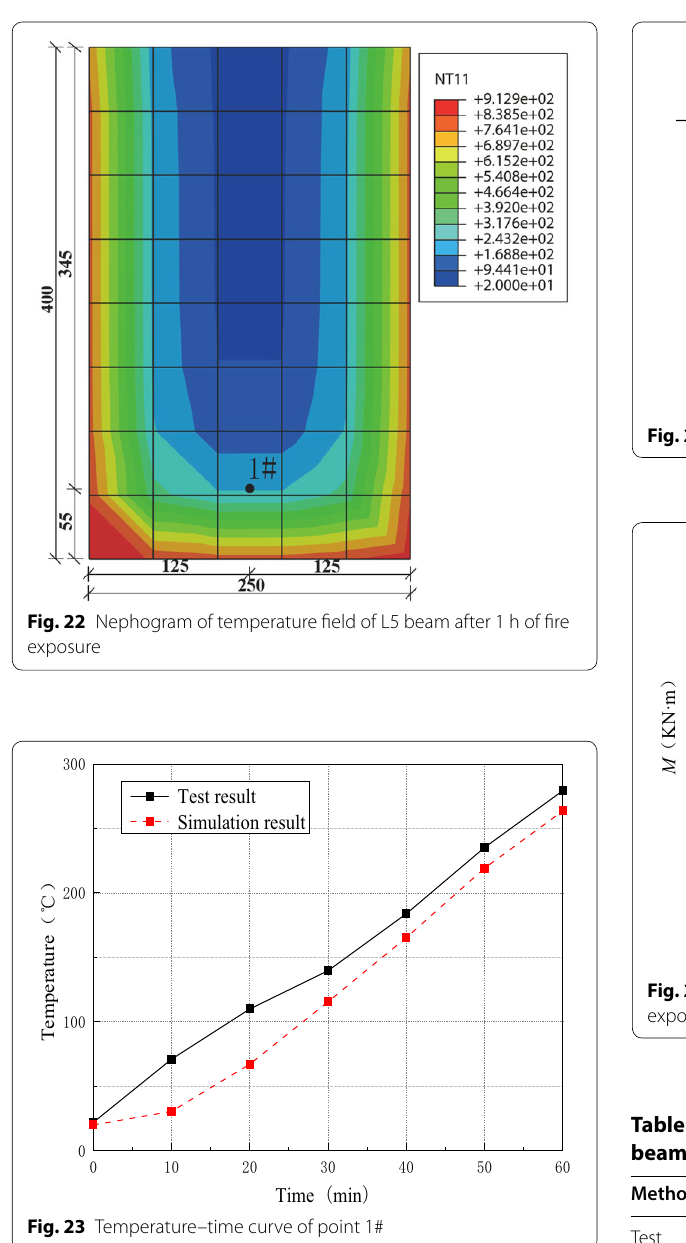
To more comprehensively compared the accuracy of the improved section method, the 500 °C isotherm method from Eurocode (BSI 2004) is now used to calcu- late the L5 beam. For a rectangular beam exposed to fire on three-sided, the schematic diagram of effective sec- tion of the beam is shown in Fig. 24. In fact, the 500 °C isotherm method is a rough calculation method for the residual flexural capacity of the beam after fire. It is based on the assumption that concrete outside 500 °C no longer provides the bearing capacity of the member, while the